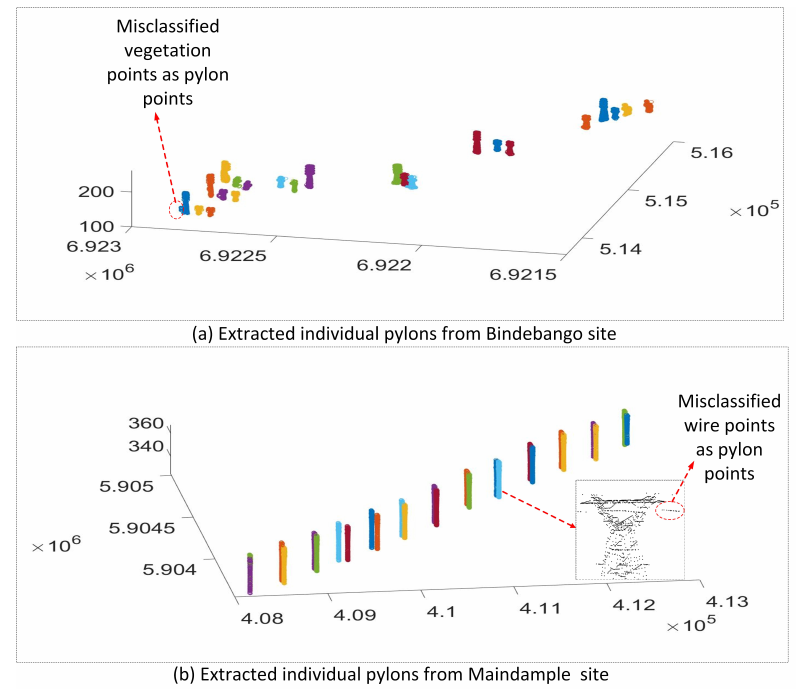
Figure 11. Individual pylons extraction in Bindebango (BDB) and Maindample (MDP) sites. Table 5. Object-based evaluation of pylons and spans on the whole test data sets (all values in percentage). Pylons Spans Data Sets Comp. Corr. Qual. Comp. Corr. Qual. MDP 98.2 100 98 90.3 100 90.3 BDB 100 100 100 100 100 100 Average 99.1 100 99 95.1 100